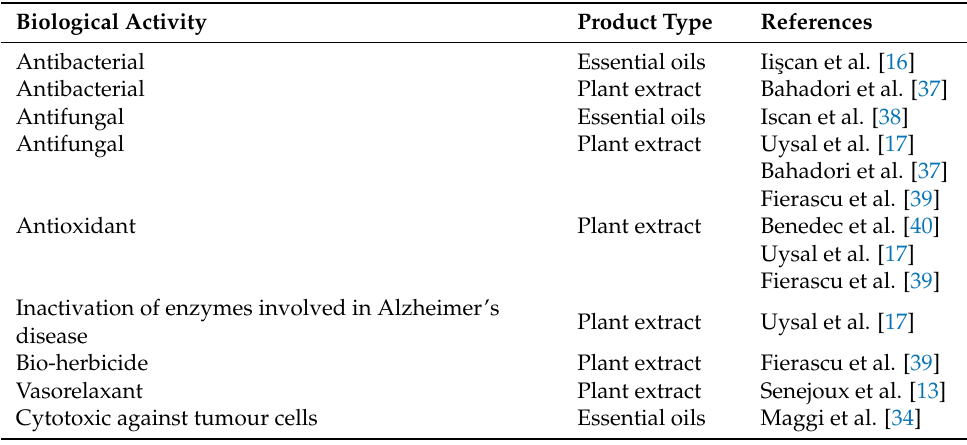
Table 3. Literature regarding the biological activity of H. sphondylium